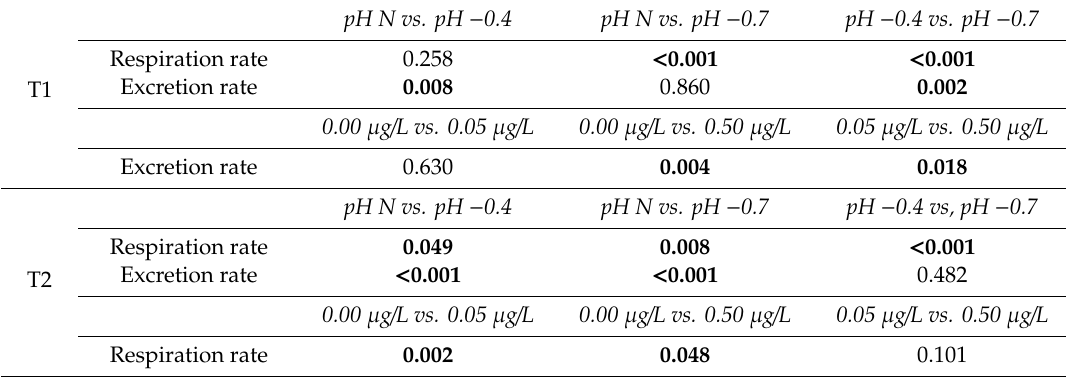
Table 3. Statistical comparisons between experimental groups. Significant results are in bold.